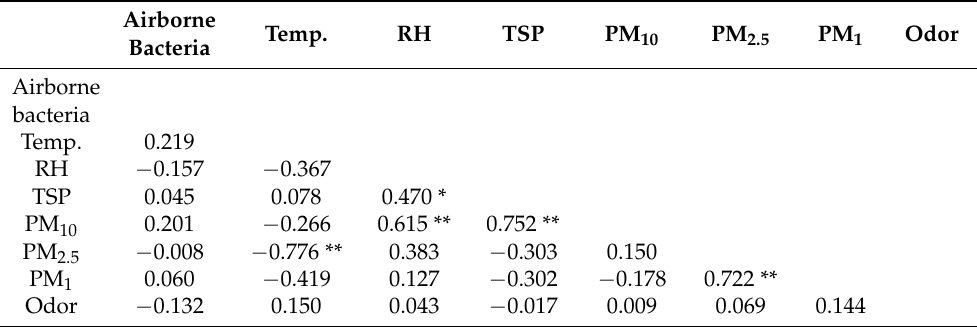
Table 2. Correlation relationships between airborne bacteria and indoor environmental factors. Airborne Bacteria Temp.